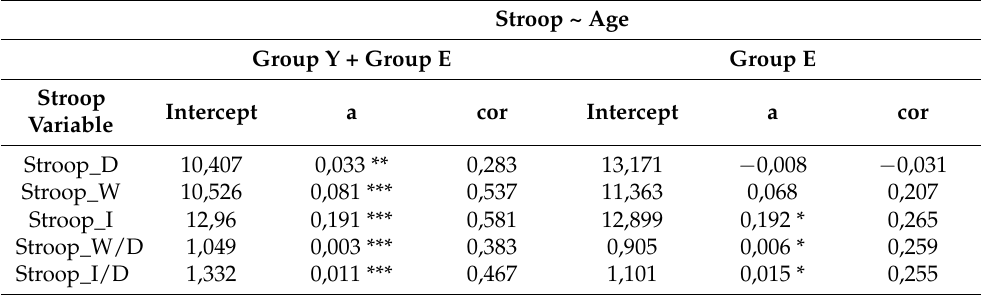
Figure 8. Correlations between Stroop scores and age for the whole population (Group Y + Group E) and Group E only. ( A ) Correlation and regression line between Stroop_I and age. ( B ) Correlation and regression line between Stroop_I/D and age. The blue dashed lines represent the regression lines for the whole population (Group Y + Group E). The red lines represent the regression lines for Group E only. The grey areas represent the 95% confidence level interval. The “ r ” represents the Pearson correlation coefficients, and the “ p ” represents the significances of the slopes of the regression lines. Table 1. Correlations and regression lines between the Stroop scores and